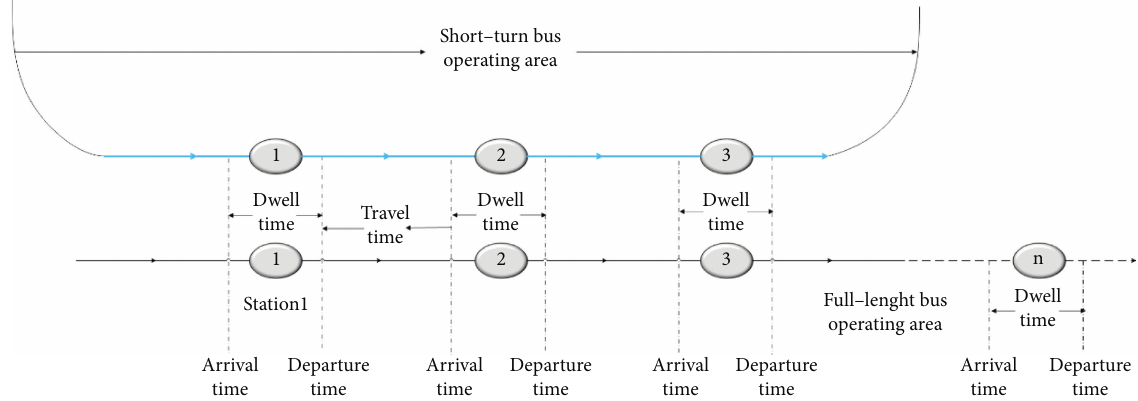
Figure 1: Sectional sketch map of bus travel